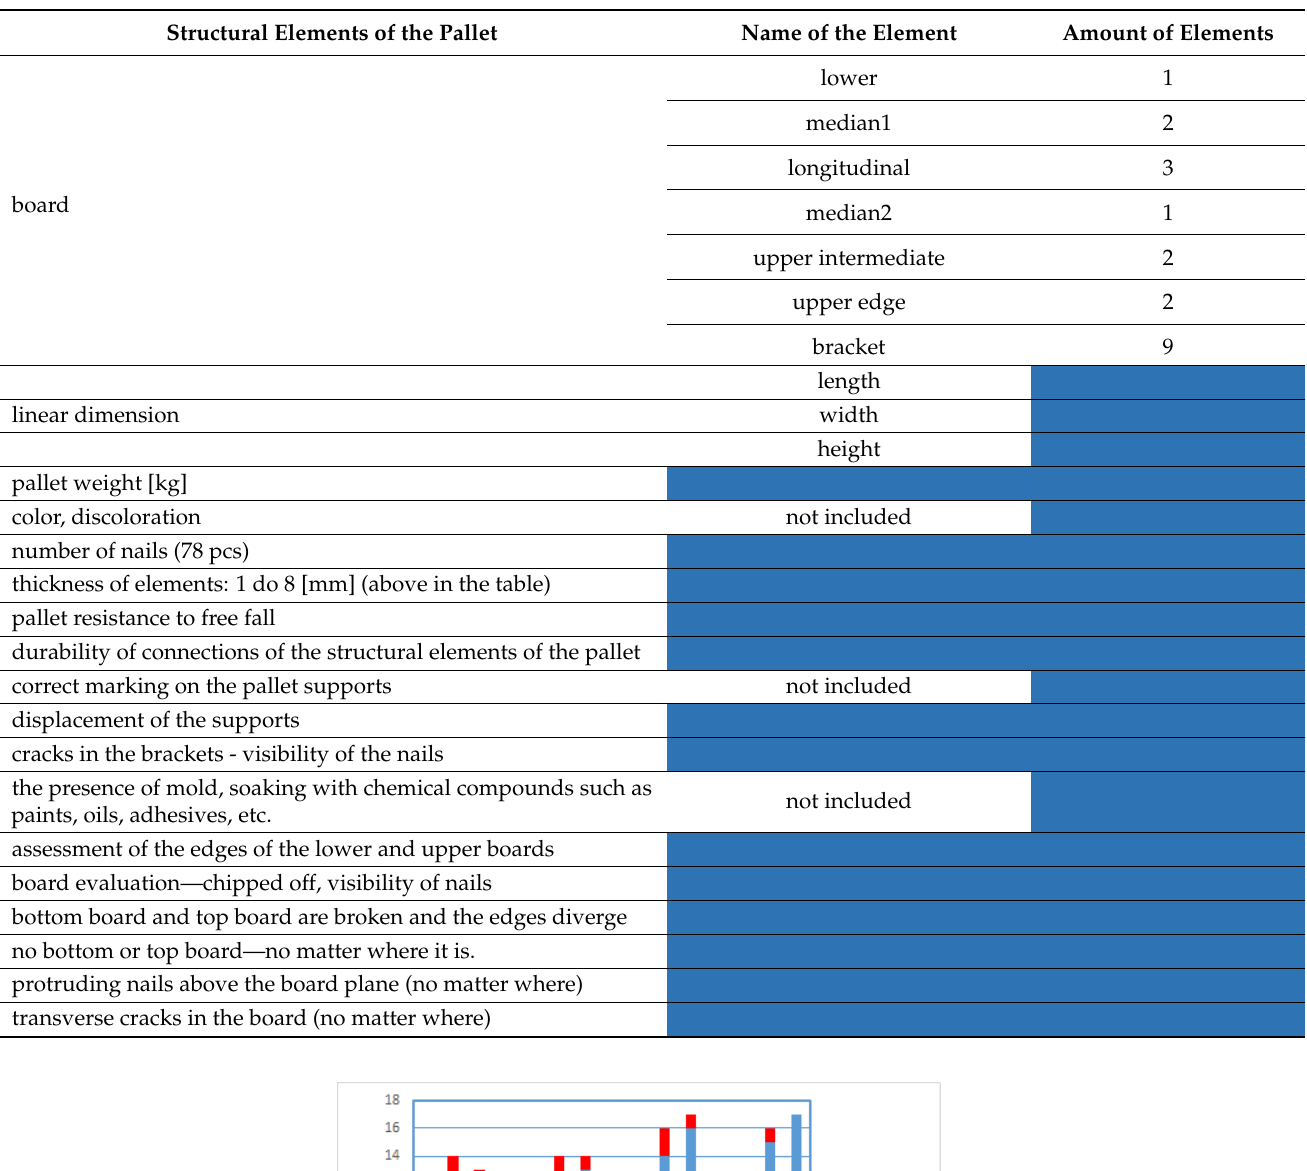
Table 2. List of parameters to be tested in the damage assessment.